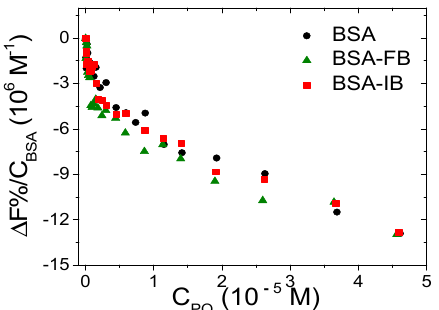
Figure 10. Binding isotherm for free bovine serum albumin (BSA) and BSA/marker titrated with PQ (FB = phenylbutazone, IB = ibuprofen); C BSA = 1.5 × 10 − 6 M, C marker = 1.5 × 10 − 5 M, C PQ from 0 to 4.6 × 10 − 5 M, NaCl 0.1 M, NaCac 2.5 mM, pH 7.0, 25.0 °C, λ exc = 295 nm, λ em = 345 nm.